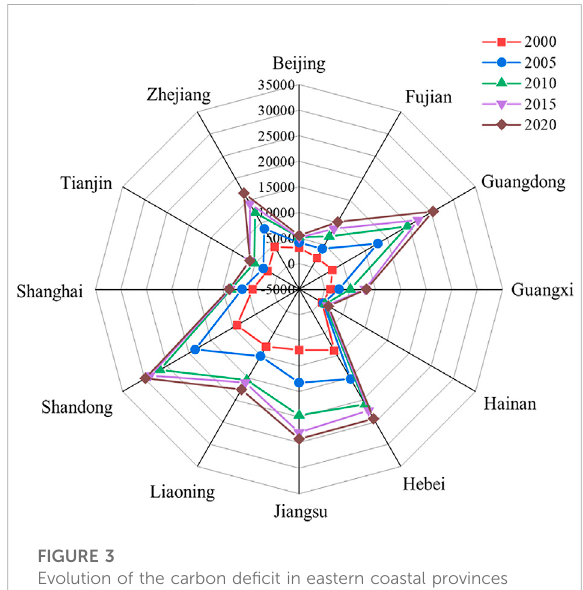
FIGURE 3 Evolution of the carbon de fi cit in eastern coastal provinces and cities from 2000 to 2020 (million